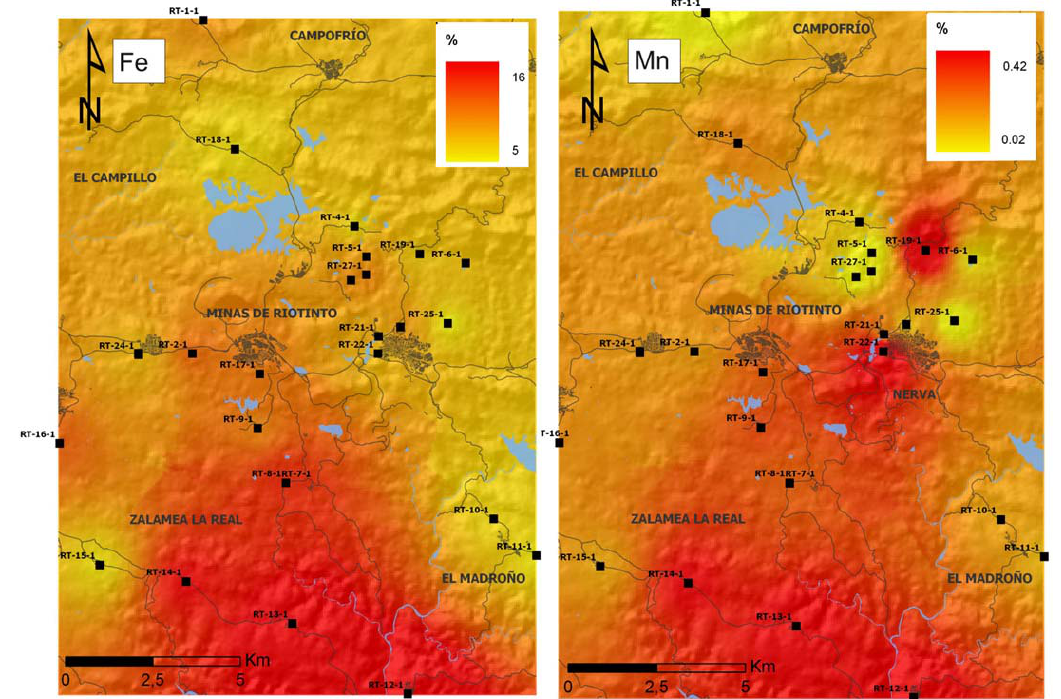
Figure 3. Spatial distribution of Fe and Mn oxides of samples studied at Riotinto Mining